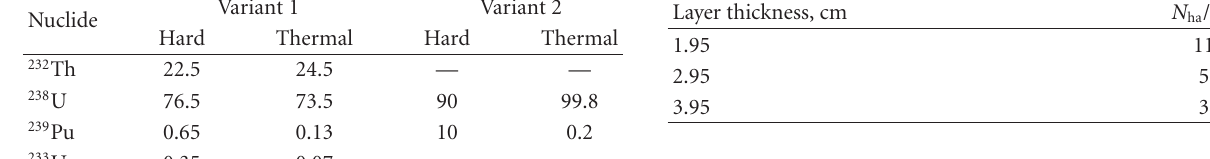
Table 3: Characteristics of reactor and hard assembly with di ff erent heavy metal